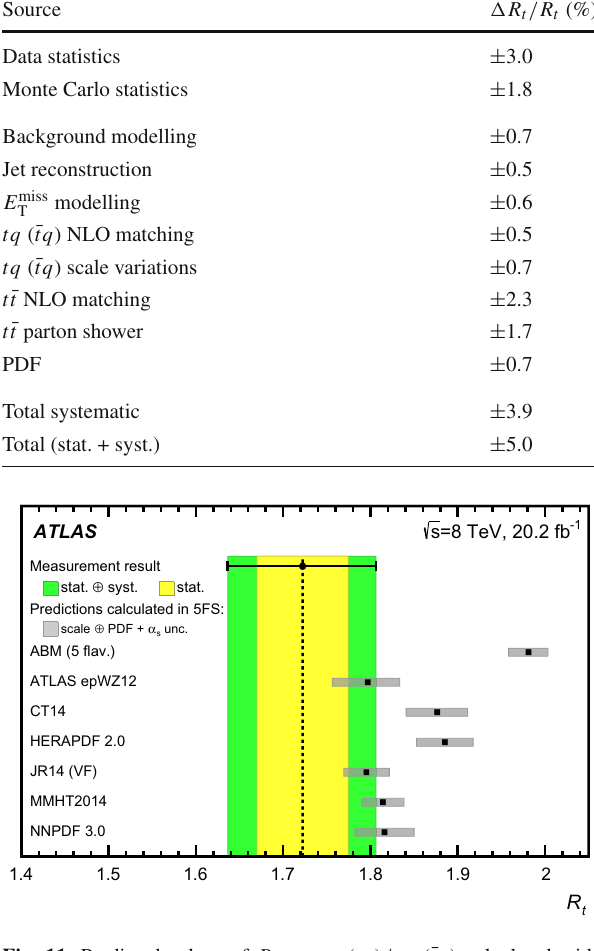
Fig. 11 Predicted values of R t = σ tot ( tq )/σ tot ( ¯ tq ) calculated with HatHor [14] at NLO accuracy in QCD [15] in the 5FS using different NLO PDF sets [79–85] compared to the measured value. The error bars onthepredictionsincludetheuncertaintyintherenormalisationandfac- torisationscalesandthecombinedinternalPDFand α S uncertainty.The dashed black line indicates the central value of the measured R t value. Thecombinedstatisticalandsystematicuncertaintyofthemeasurement is shown in green , while the statistical uncertainty is represented by the yellow error band . The uncertainty in the measured R t value does not include the PDF components for this comparison Table 6 Slopes a of the mass dependence of the measured cross-